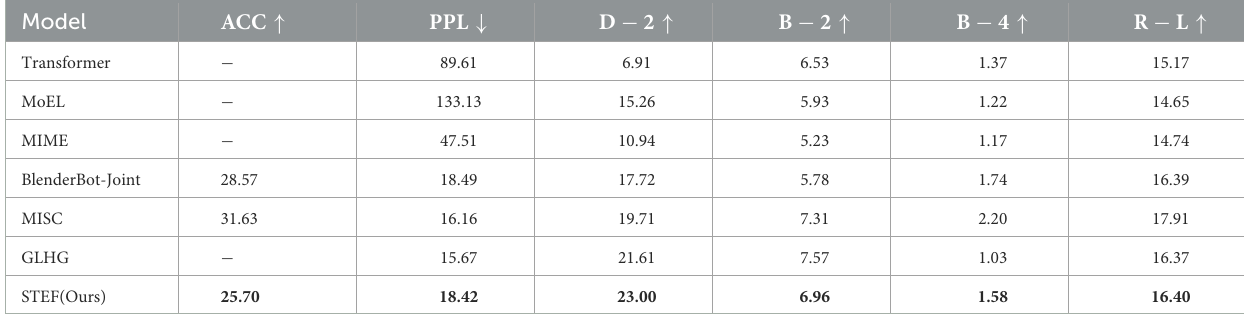
TABLE 1 Results of automatic